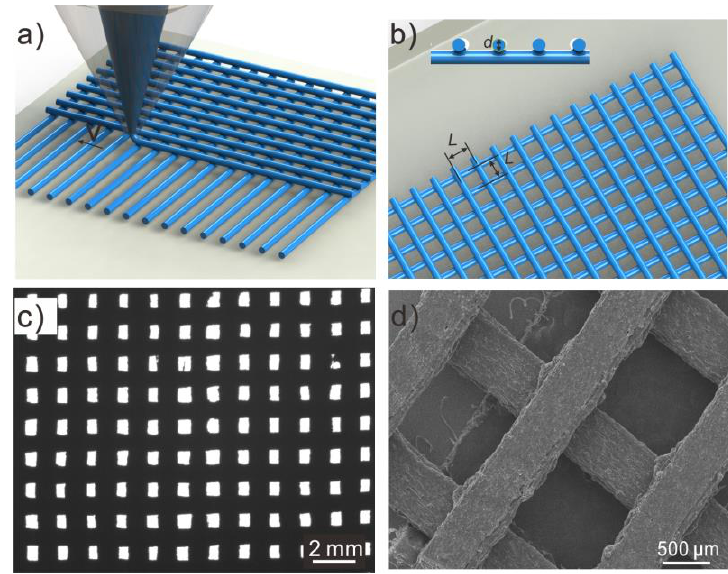
Figure 1. ( a ) Typical schematic illustration of the fused deposition modeling (FDM) 3D printing process. ( b ) Design of 3D printing orthogonal mesh with parameter of diameter, layers, and spacing. ( c , d ) Optical and SEM photographs of Fe/PLA composites mesh with through hole.